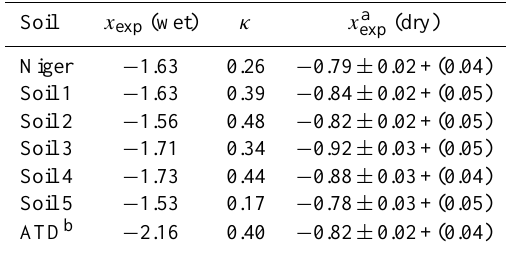
a represents experimental exponent determined from dry generation method Kumar et al. (2011). Values in parentheses indicate change in magnitude of x exp from change in dynamic shape factor between 1.1 and 1.5. b Two peaks were observed for ATD. Wet atomization values here represent experi- mental results from the first (most hygroscopic)